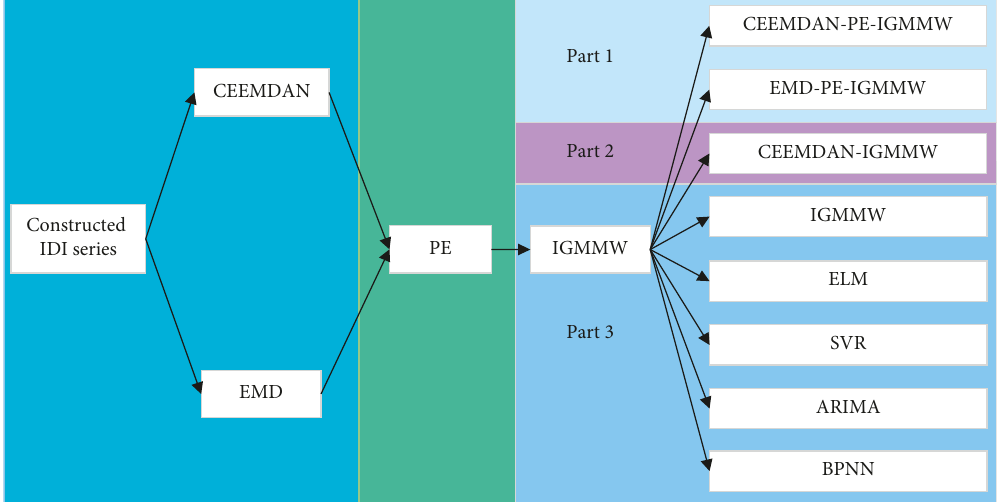
Constructed IDI series